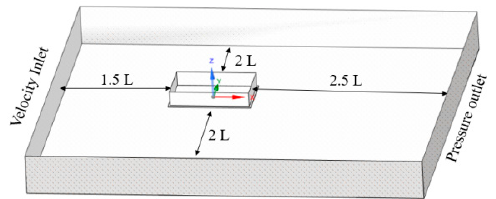
Figure 4. Computational domain in Ansys Fluent.